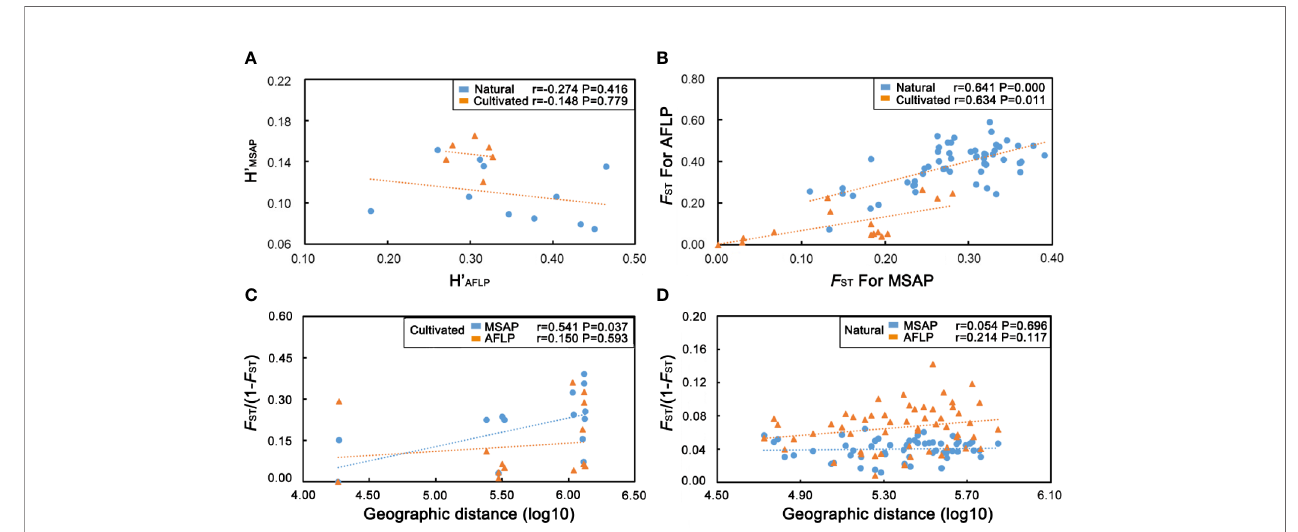
FIGURE 5 | Correlations between epigenetic and genetic (A) diversity ( H ′ ) or (B) variation ( F ST ) in C. yanhusuo populations. Spatial autocorrelation pattern detected for epigenetic variation ( F ST /1- F ST ) in cultivated (C) and natural (D) populations. Geographic distance is log-transformed. r = correlation coef fi cient, P = signi fi cance of the